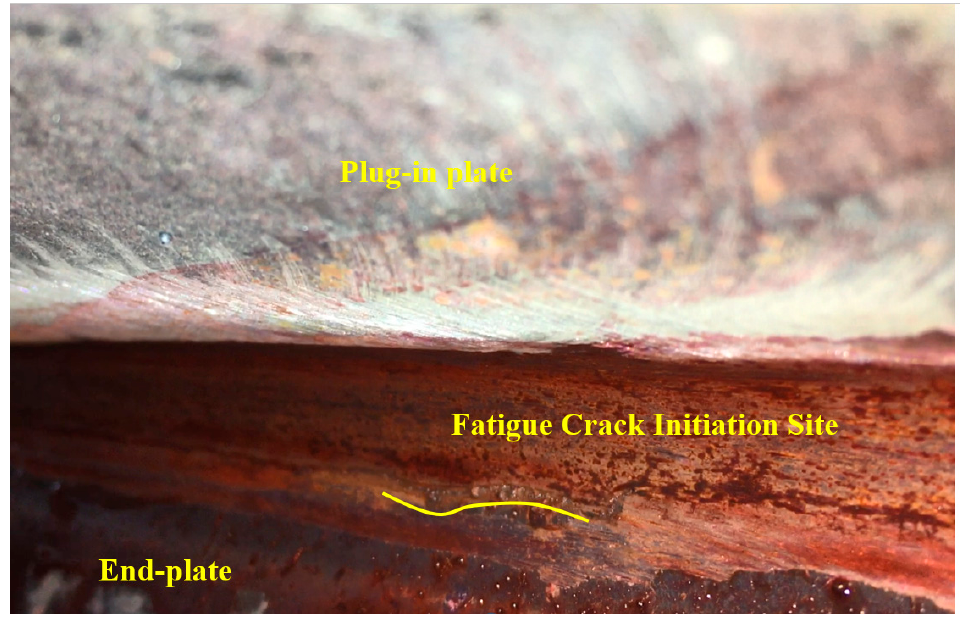
Figure 14. Cracks originated at the weld toe on the end